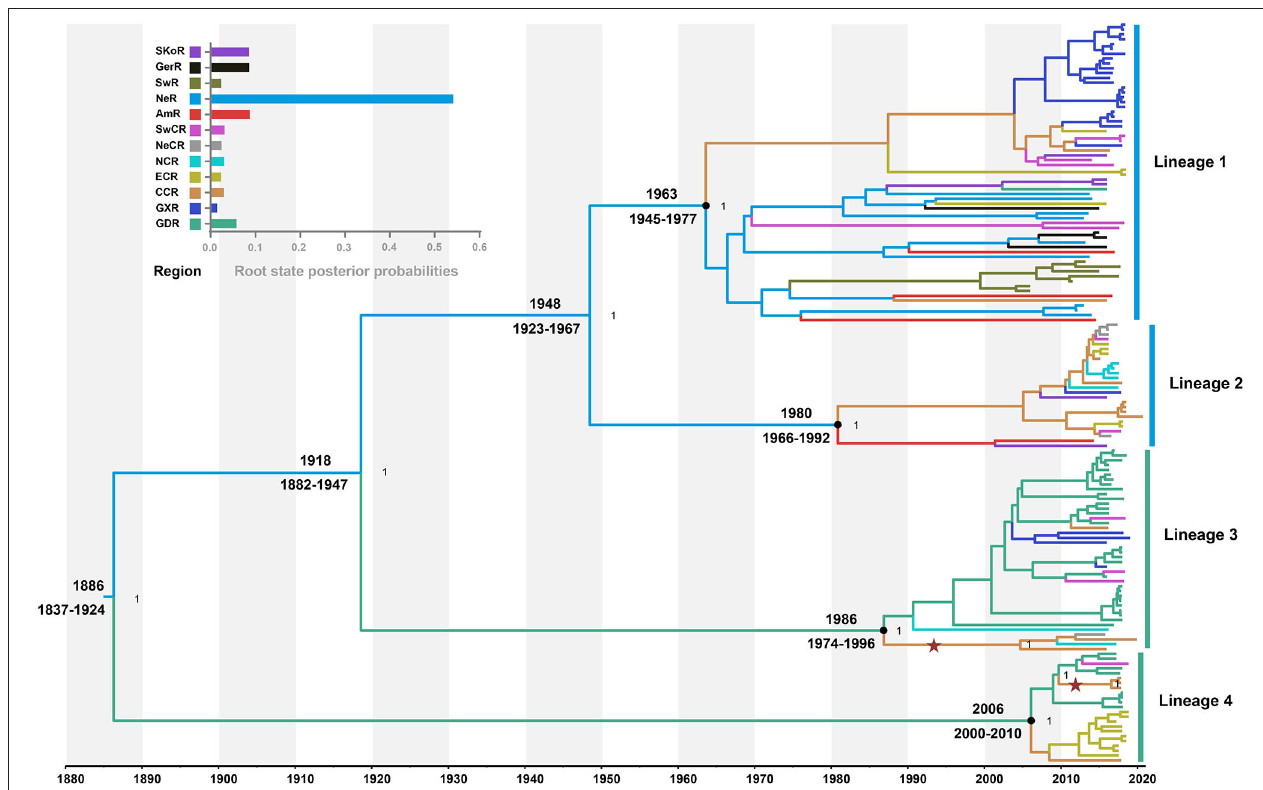
FIGURE 2 | Time-scaled maximum clade credibility tree inferred from E2 gene dataset. Black dots indicate the most recent common ancestors for lineages 1, 2, 3, and 4 with support of posterior probability = 1.00. Branch colors denote inferred region states. The root state posterior probabilities of the geographic regions are shown in the inset panel. SKoR, South Korea Region; GerR, Germany Region; SwR, Switzerland Region; NeR, Netherlands Region; AmR, USA Region; SwCR, Southwest China Region; NeCR, Northeast China Region; NCR, North China Region; ECR, East China Region; CCR, Central China Region; GXR, Guangxi Region; GDR, Guangdong Region. Introduction of atypical porcine pestivirus into CCR from GDR is marked with stars.